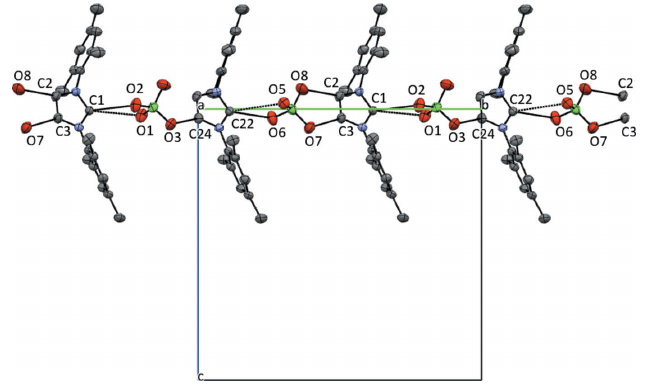
Figure 2 Packing diagram showing hydrogen-bonding interactions as dashed lines, viewed along the [100] axis.